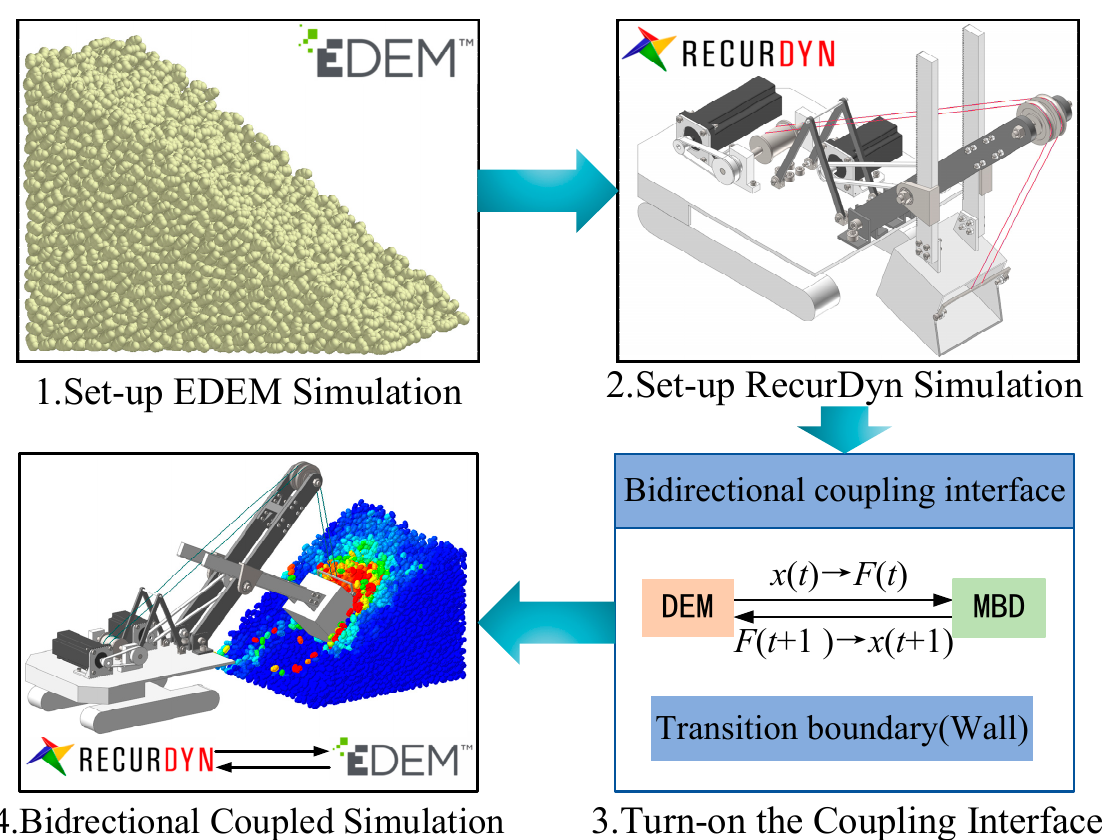
Figure 10. Bidirectional coupled simulation process.